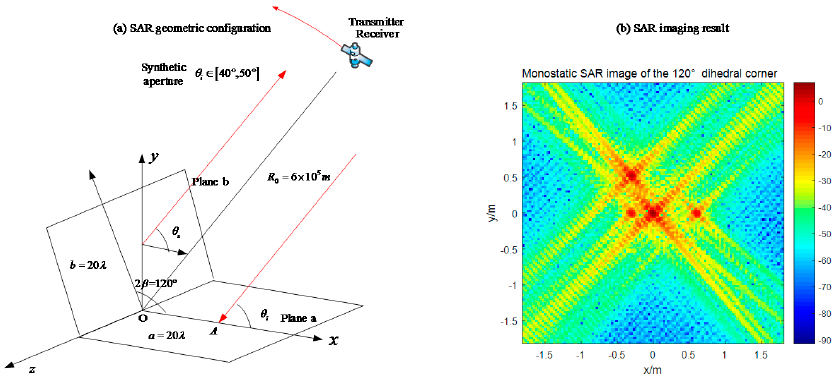
Figure 21. Monostatic SAR image of a 120° dihedral corner ( a ) geometric configuration; ( b ) imaging result.